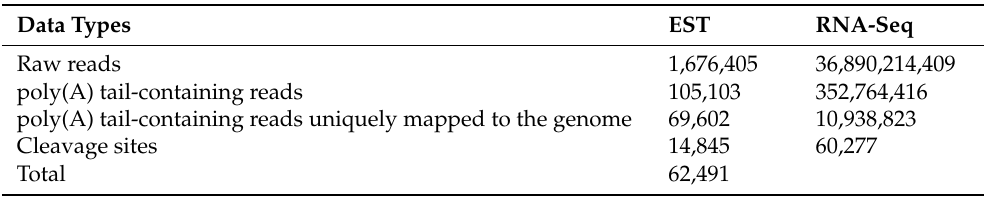
Table 1. Summary of all mRNA transcripts retrieved from the EST and RNA-seq databases of Sus scrofa.